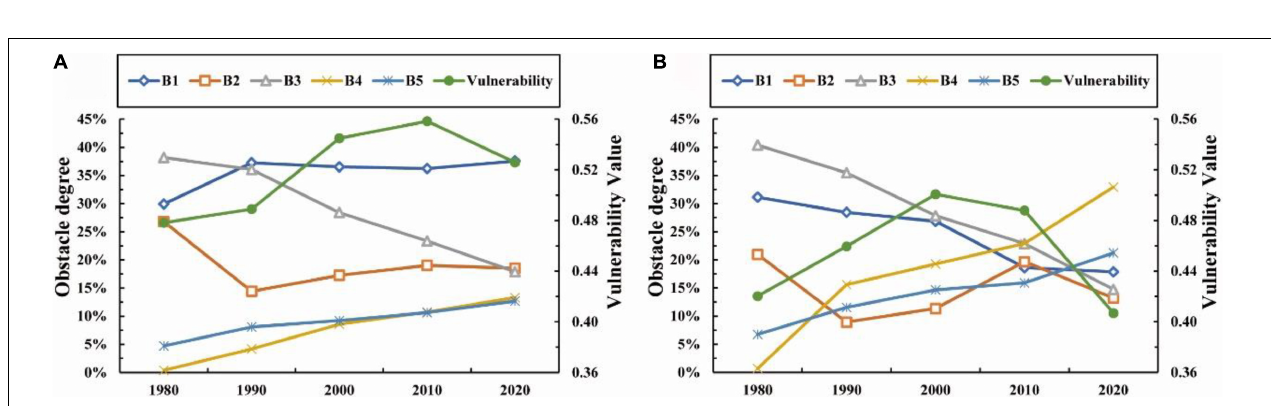
FIGURE 7 | Temporal variations in the main influential elements and vulnerability to coastal erosion in the entire study area (A) and Futian District (B) . The specific meaning of the characters in the figure and the corresponding relationship between factors are shown in phase 1 of Figure 2 .